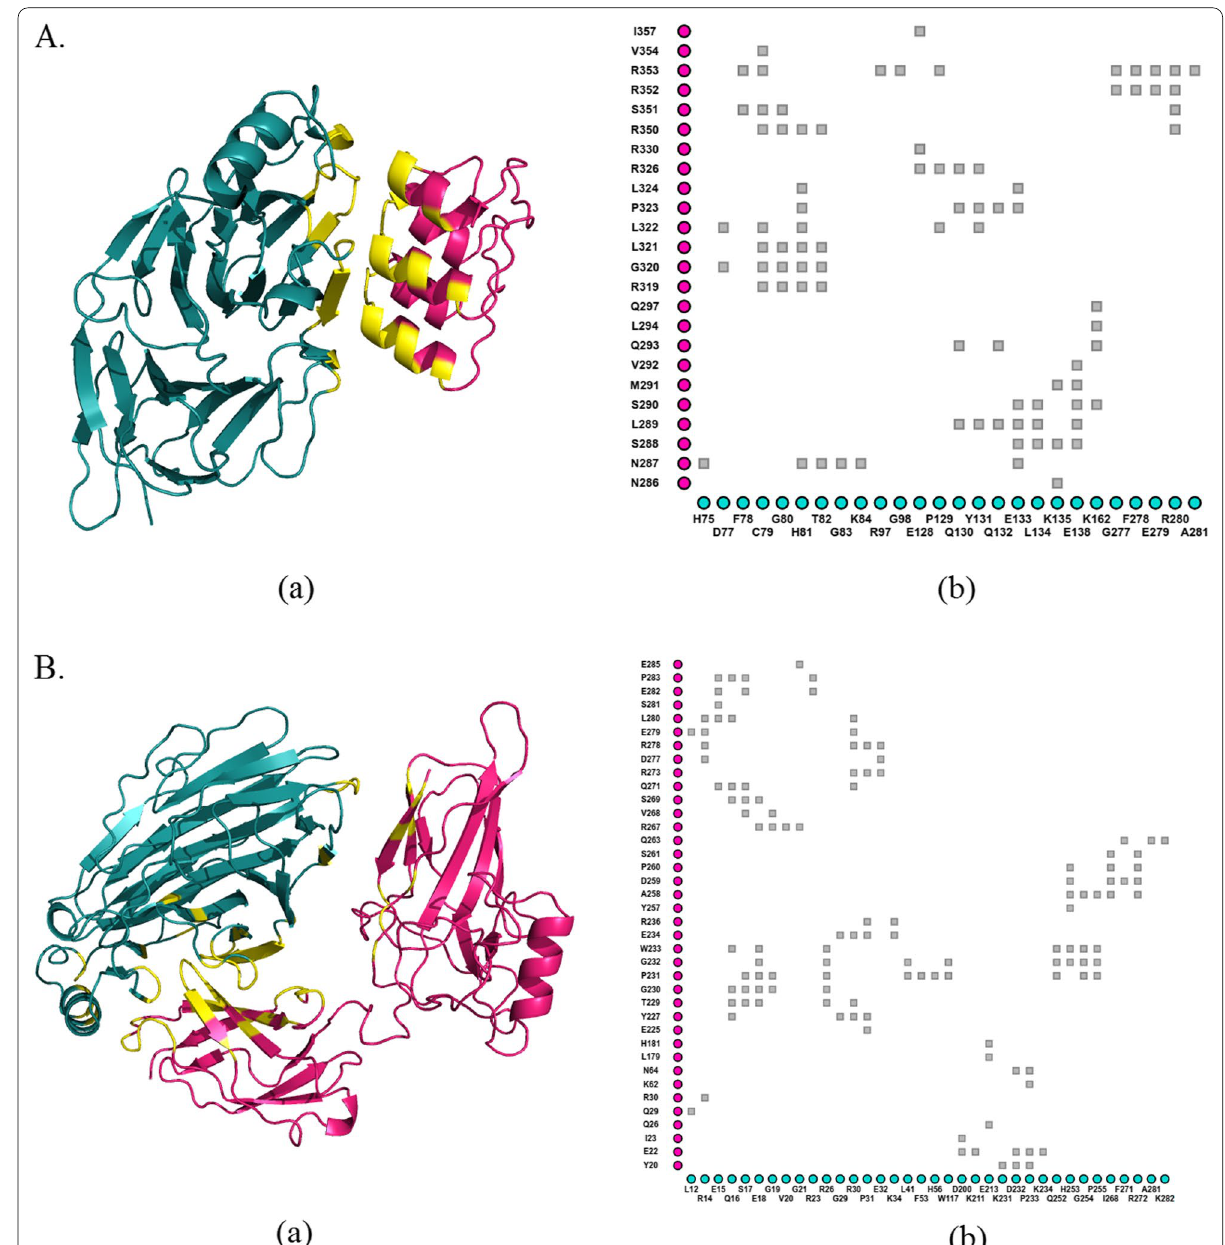
Fig. 1 Interactions between pirin and its binding partners. Docking was performed between Fe 2 + conformation of pirin and three ankyrin repeat domains (ANK 5-7) of BCL3 ( A ), as well as, Fe 3 + conformation of pirin and Rel homology domain (RHD) of p65 (residues 19-306) ( B ). The protein–protein complex structures were depicted using PyMOL (Schrodinger and Delano 2020) (Aa and Ba). Pirin is illustrated in deep teal and its partners in hot pink. Protein–protein interfaces are delineated in yellow. Inter-residue interactions are delineated with iCn3D (Wang et al. 2020) (Ab and Bb). Each gray square represents contacts/interactions within 6 (Å). Residues of pirin are displayed in the x-axis and those of its binding partners are in the